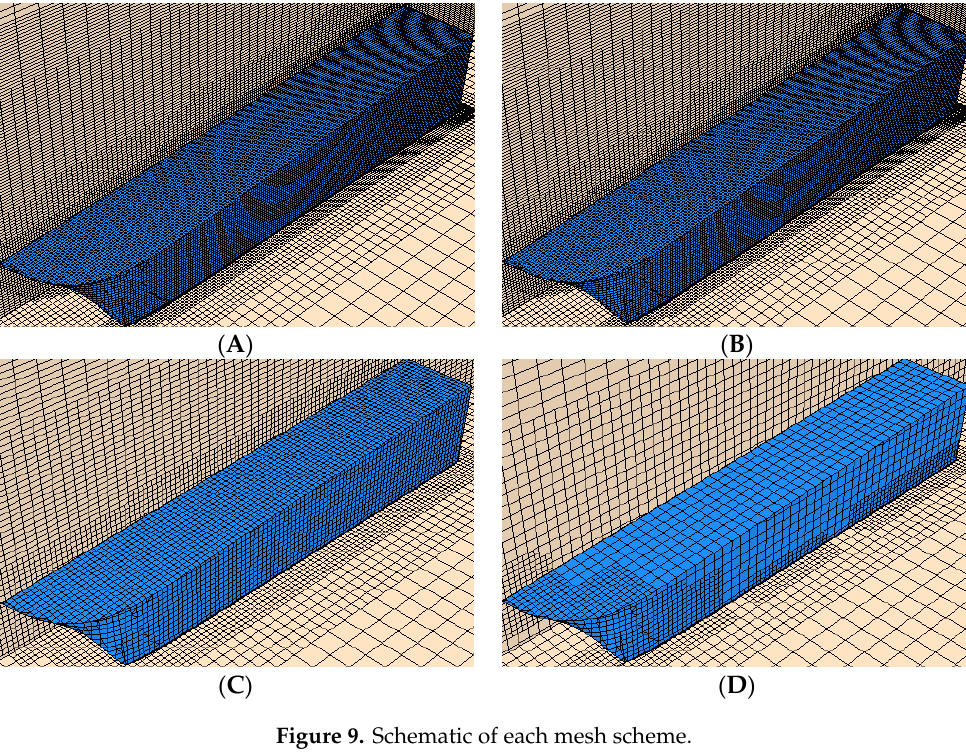
Figure 9. Schematic of each mesh scheme. Table 5. Comparison of numerical and experimental values for each mesh